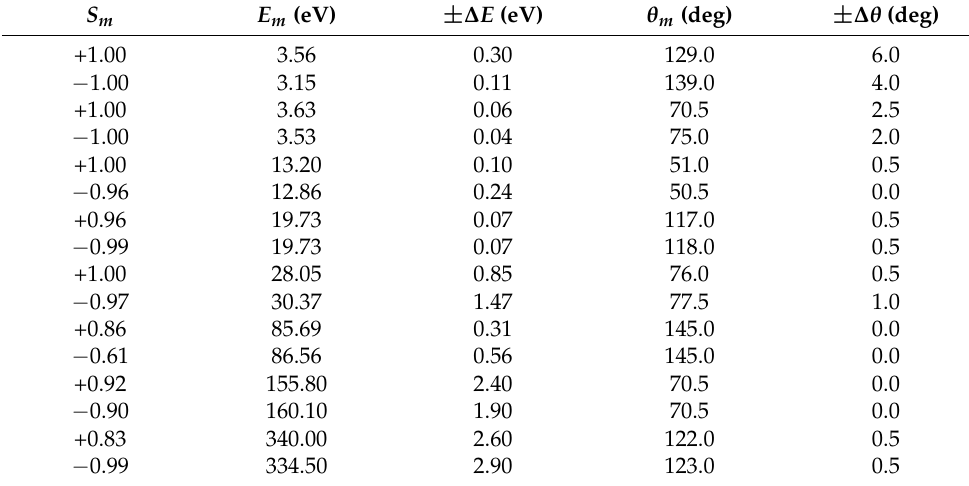
Table 4. Maximum spin polarization points, along with their positions and deviations in energy ( ∆ E ) and angle ( ∆ θ ) from the respective critical minimum positions, for e − − Cu scattering